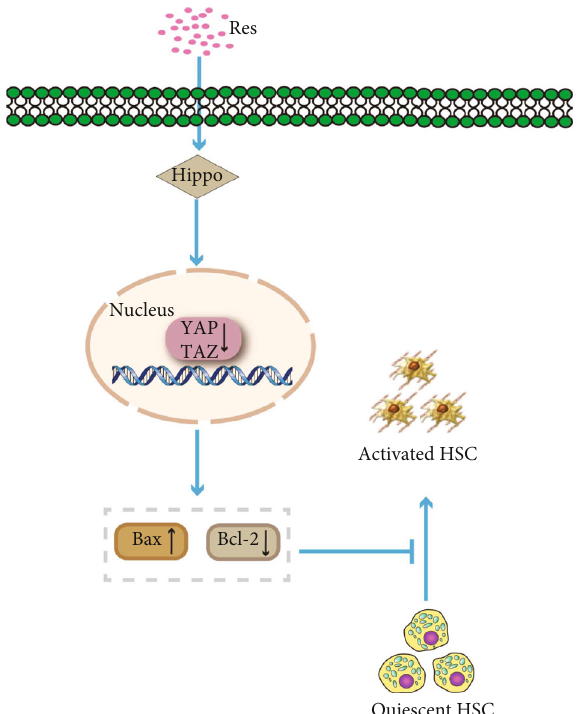
Figure 9: Schematic representation of the working model by which Res suppresses. HSC activation via the Hippo